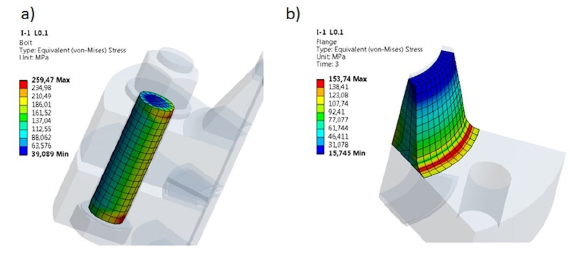
Figure 16: Equivalent stress distribution in the joint a) in root of the bolt b) in flange